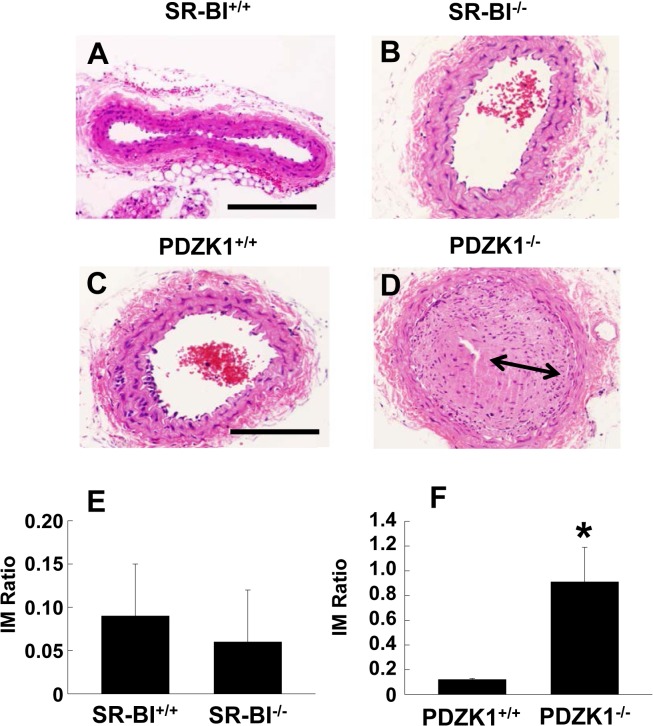
PDZK1 deletion causes exaggerated carotid artery neointima formation.A, B. Male SR-BI+/+ and SR-BI-/- mice (10–12 weeks of age) underwent unilateral left carotid artery ligation for the evaluation of neointima formation. Arteries were harvested 21d later, and representative images of sections from SR-BI+/+ and SR-BI-/- mice stained with hematoxylin and eosin are shown. The scale bar indicates 100 μm. C, D. Neointima formation was also evaluated in male PDZK1+/+ and PDZK1-/- mice. Neointima is indicated by arrow. E. Summary data for intima-to-media (IM) ratio for SR-BI+/+ versus SR-BI-/-. F. Summary data for IM ratio for PDZK1+/+ versus PDZK1-/-. In E and F, values are mean±SEM, n = 7–9, *p<0.05 vs. PDZK1+/+.